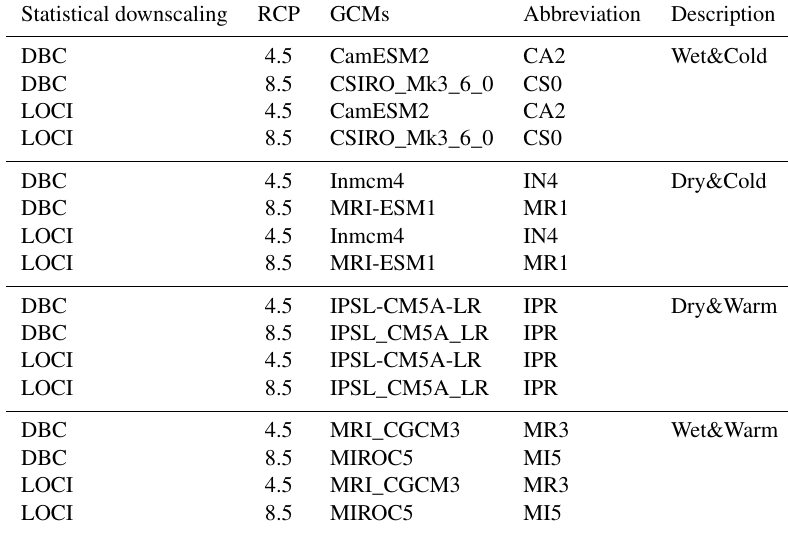
Table 2. The future climate change scenarios for the upper Beas basin. Statistical